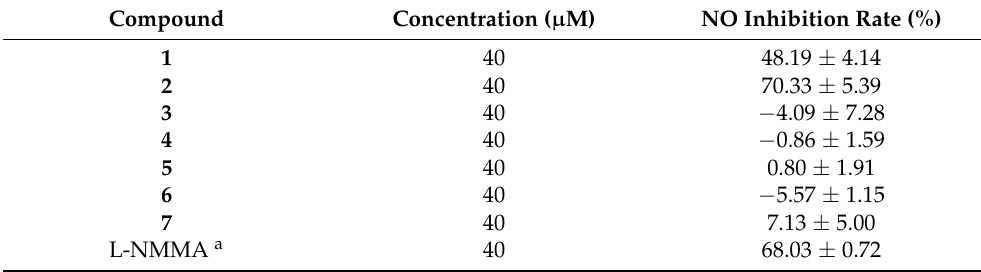
Figure 4. Inhibitory effects of compounds 1 – 7 on NO production in LPS-induced RAW 264.7 cells. Experiments were performed in triplicate, and the data are presented as the mean ± SD. ** p < 0.01, *** p < 0.001 vs. LPS group. NS, not significant by T -test.